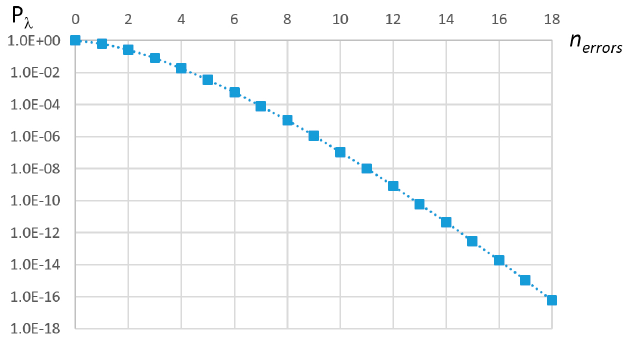
Figure 6. Plot of P λ ( ≥ n errors ; 1/ λ Figure 6 . Plot of P λ ( ≥ n errors ; 1/ λ )